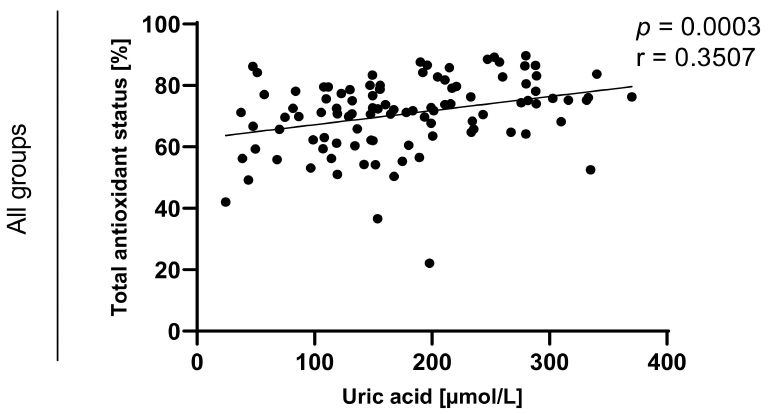
Figure 7. Correlation between uric acid and TAOS (total antioxidant status) among e-cigarettes users, traditional cigarettes smokers and non-smokers.